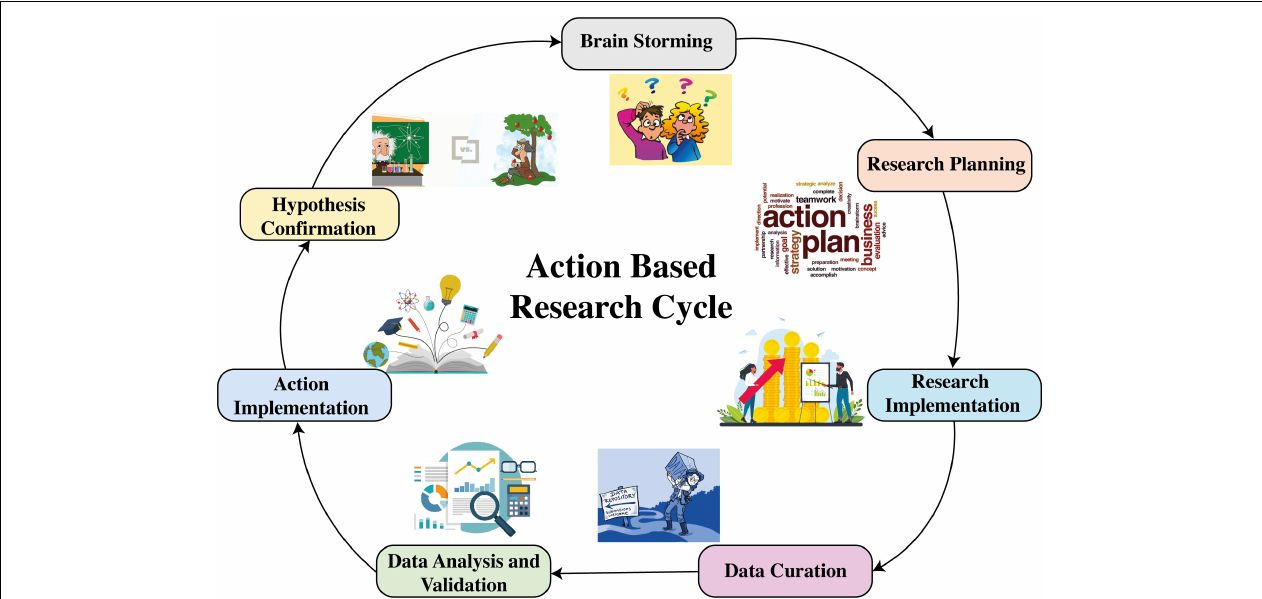
FIGURE 4 | Important components of action-based research critical to ensure food security research